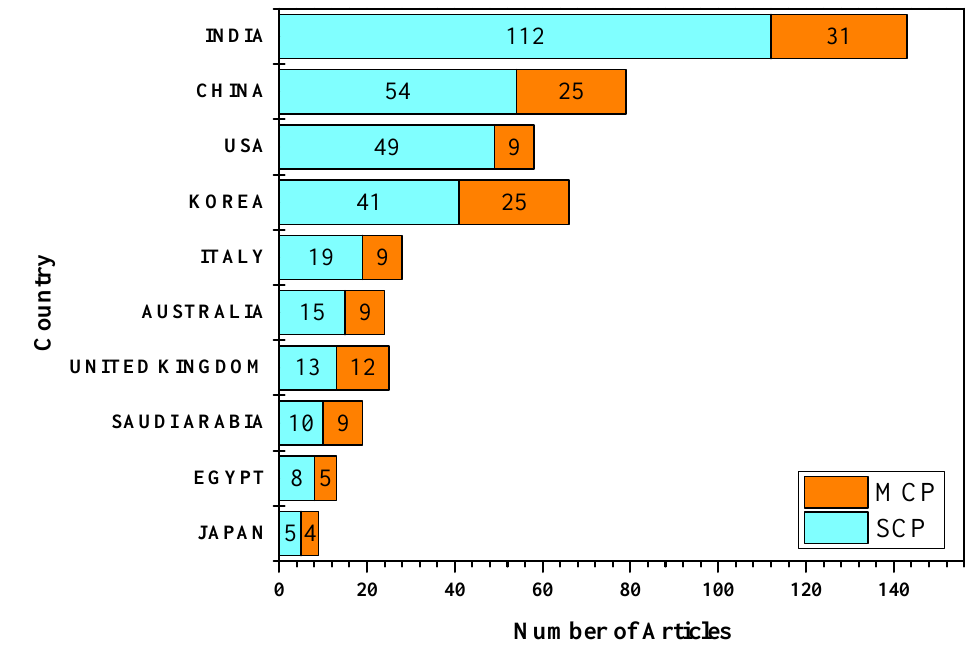
Figure 7. Number of articles based on Corresponding author, MCP: Multiple Countries Publications, SCP: Single Country Publications.